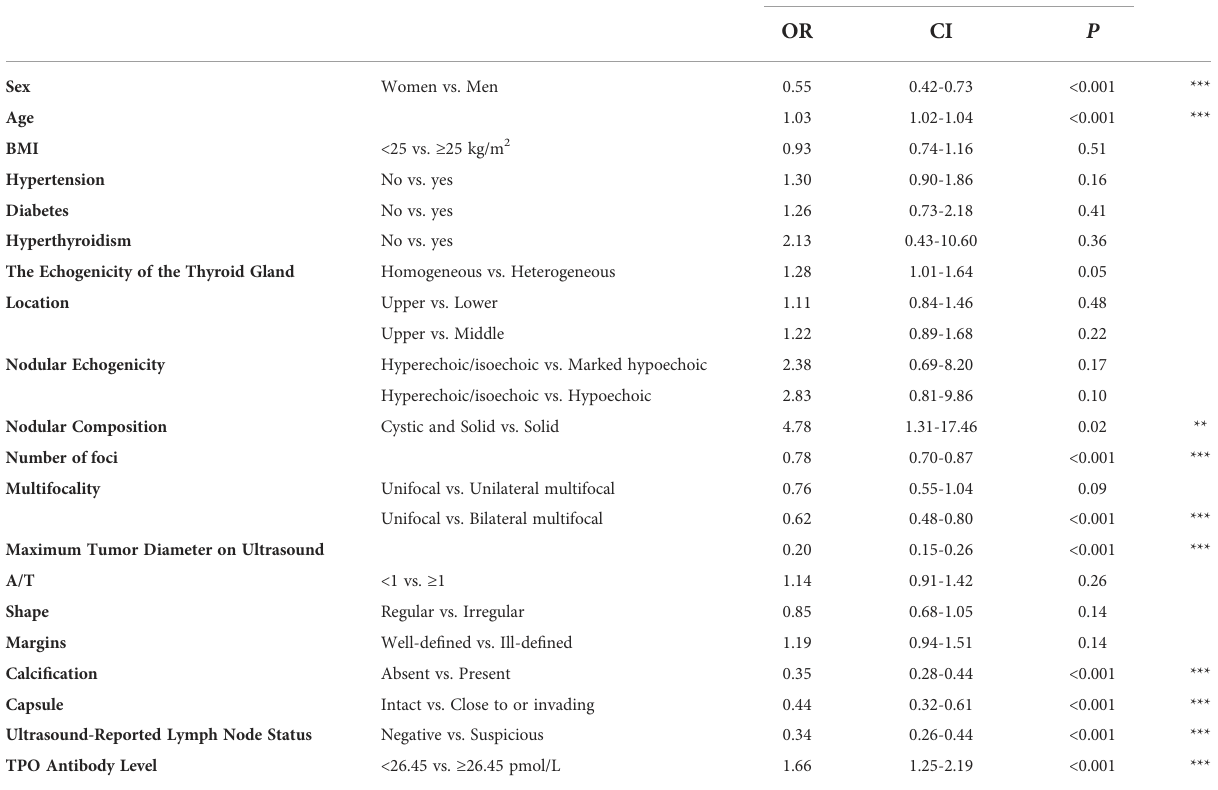
TABLE 3 Univariate analysis of the predictive